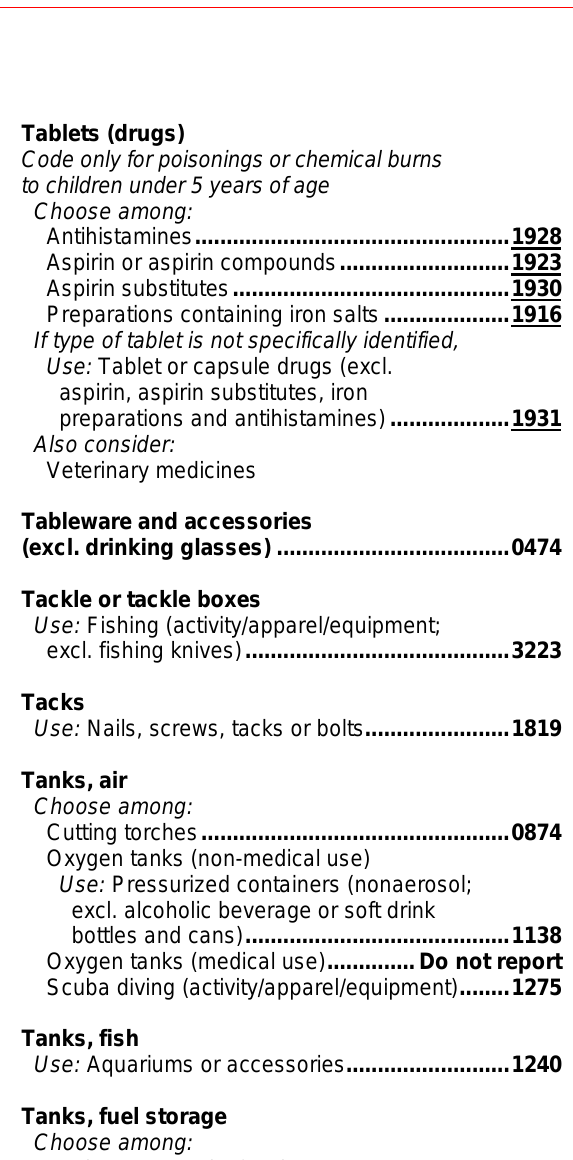
Table tennis (activity/apparel/equipment) ........ 1269 Tablet Computer Use: Computers (equipment